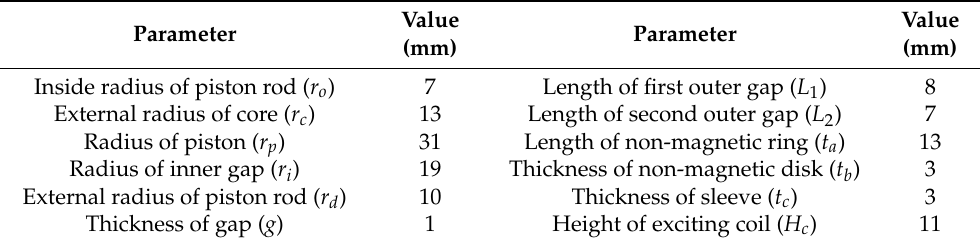
Table 1. Main structural dimensions of the proposed MR